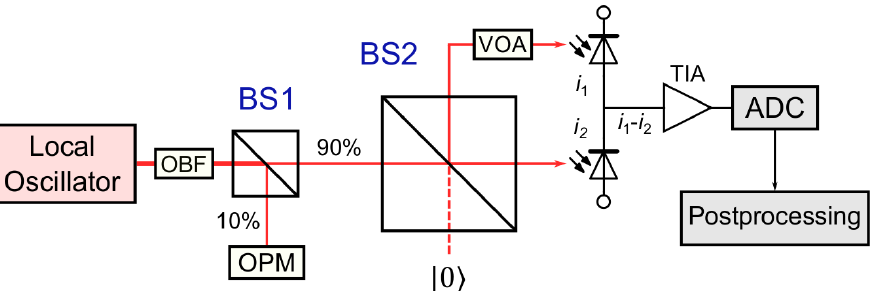
Figure 2. Schematic representation of the implemented QRNG. A laser is split by a BS with one of its input ports blocked (BS2) and the subsequent photocurrents are subtracted. The resulting signal, i 1 − i 2 , is amplified, digitized, and processed to obtain a string of unbiased random